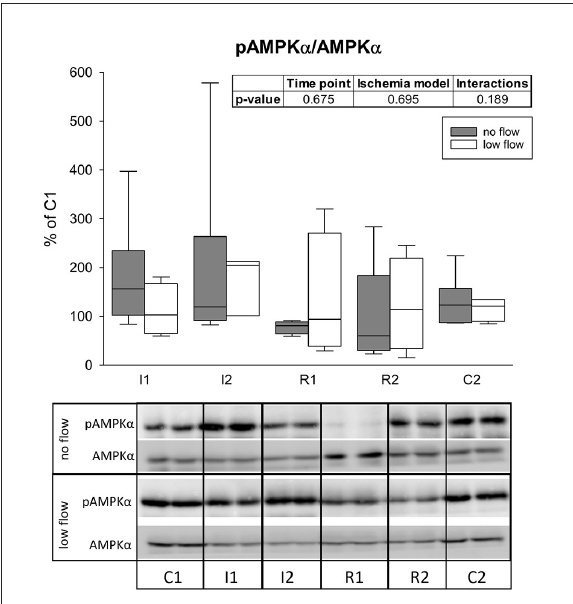
FIGURE5 The ratio of pAMPK α /AMPK is not changed significantly during ischemia and reperfusion in equine jejunum epithelium. The amount of phosphorylated AMPK α in relation to its total level after 1 and 2h of ischemia and reperfusion each is given relative to C1 ( = 100%). Boxes and error bars show the median, 10th, 25th, 75th, and 90th percentiles (no flow: gray; low flow: white); N = 6 (no flow) or 4 (low flow). The insert shows the result ( p -values) of the statistical analysis using a two-way RM ANOVA. Representative blots are shown